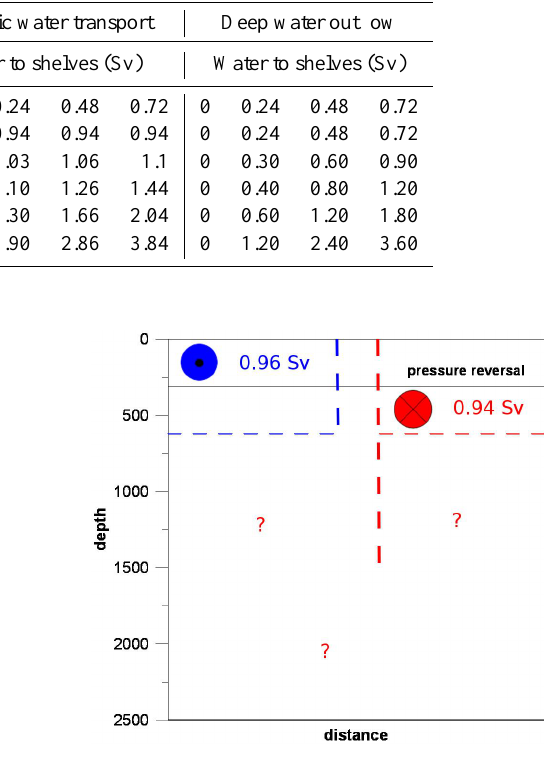
Fig. 21. Idealised baroclinic exchanges through Fram Strait, where the upper layer in the East Greenland Current is created by